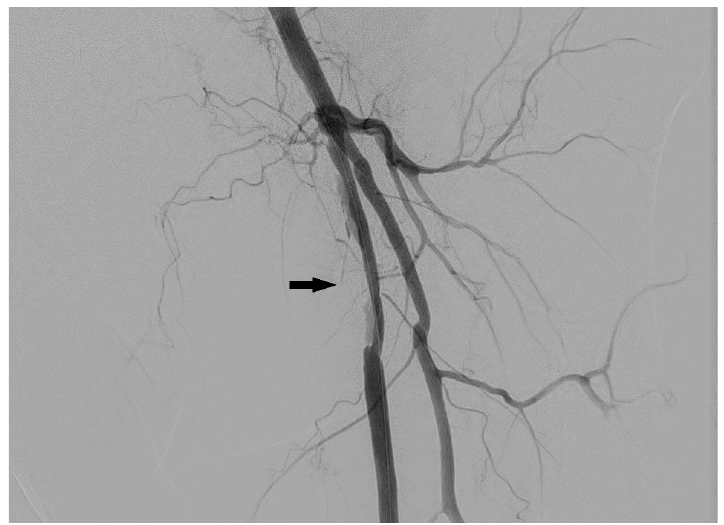
Figure 7. Post-angioplasty superficial femoral artery acute dissection (black arrow).